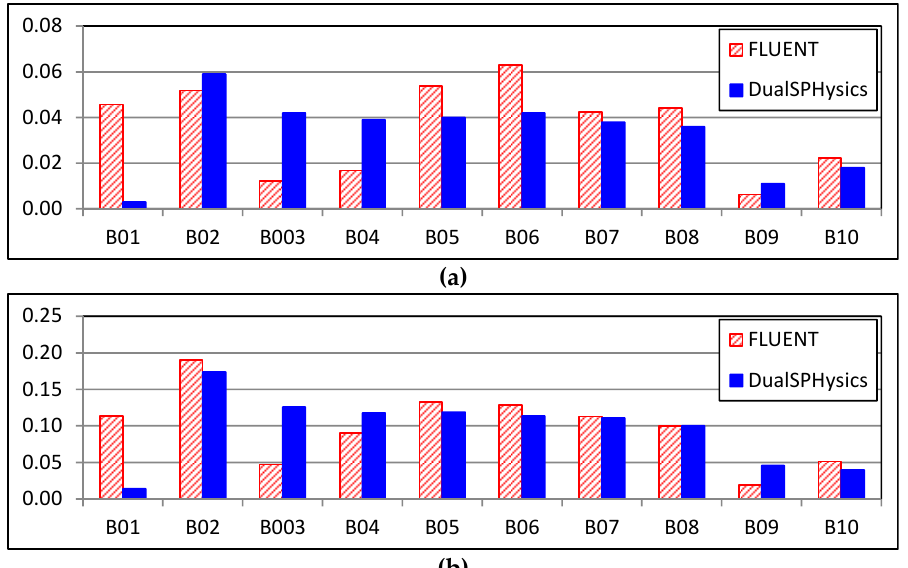
Figure 21. Mean ( a ) and maximum ( b ) wave overtopping discharge (m 3 /s/m) along the dike at gauges B01 to B10 for FLUENT and DualSPHysics.